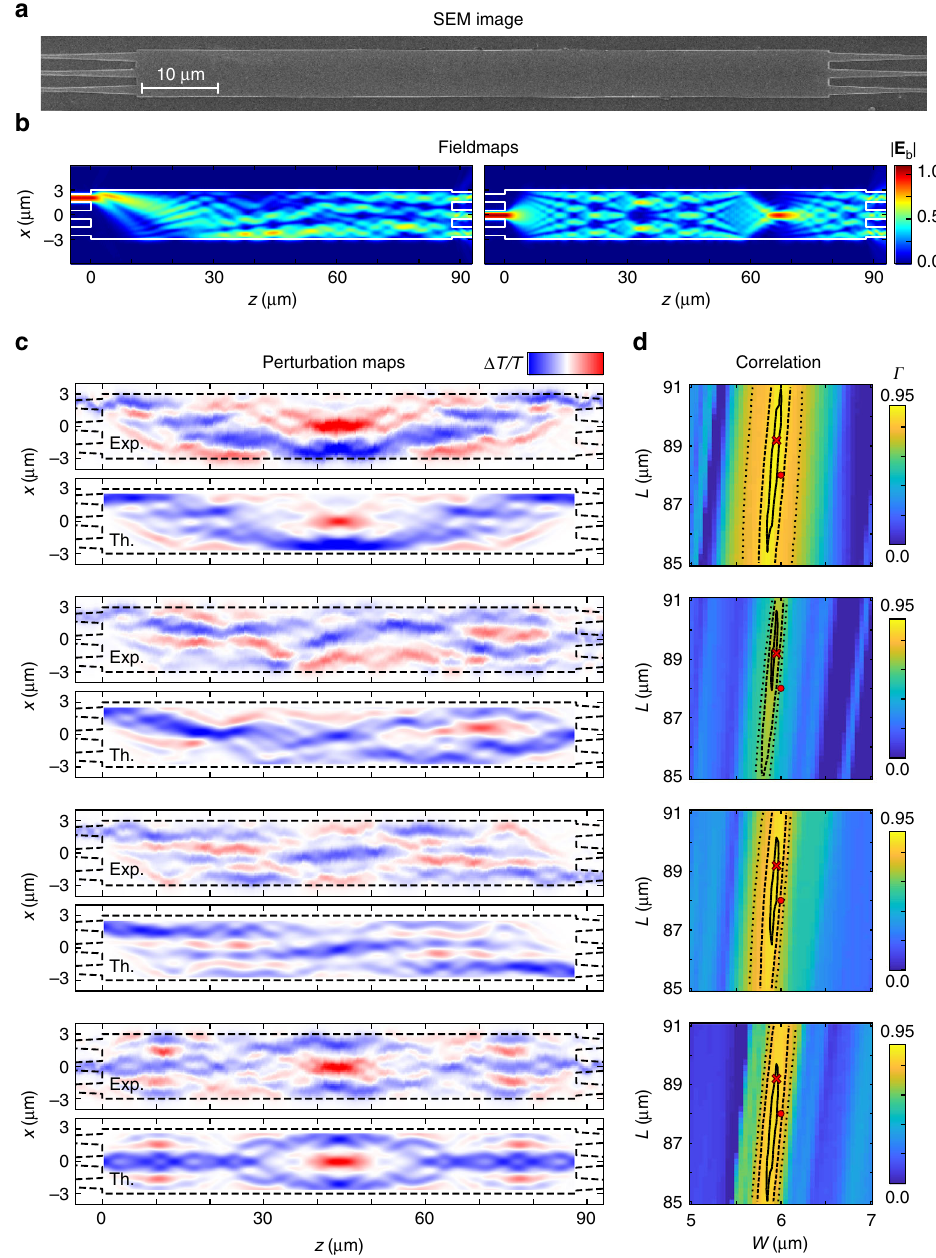
Fig. 4 Experimental investigation of a 3 × 3 MMI and comparison with predictions. a – d Same as in Fig. 3 for a MMI with designed length L = 88.0 μ m and width W = 6.0 μ m, and SEM measured length L = 89.2 μ m and width W = 5.95 μ m. The scale has been halved in the propagation axis for b , c . The amplitude of the color bar in c is ±0.3 for the experimental maps and ±0.4 for the theoretical